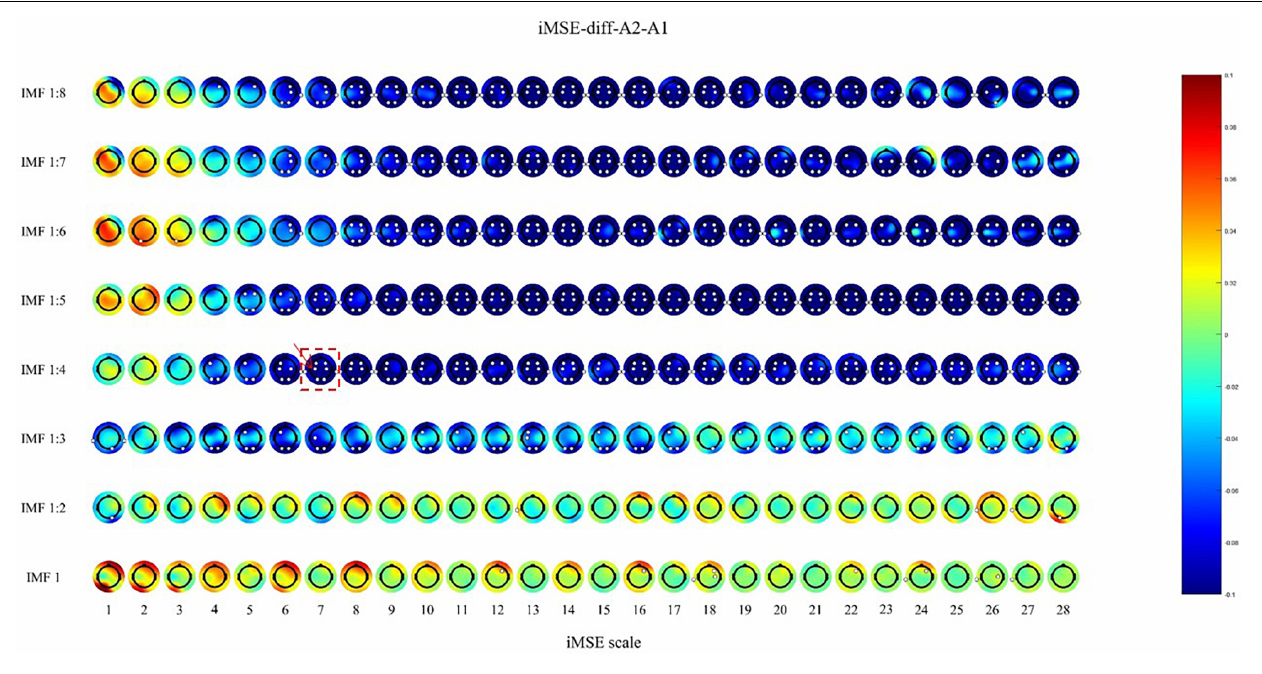
Frontiers in Psychiatry |